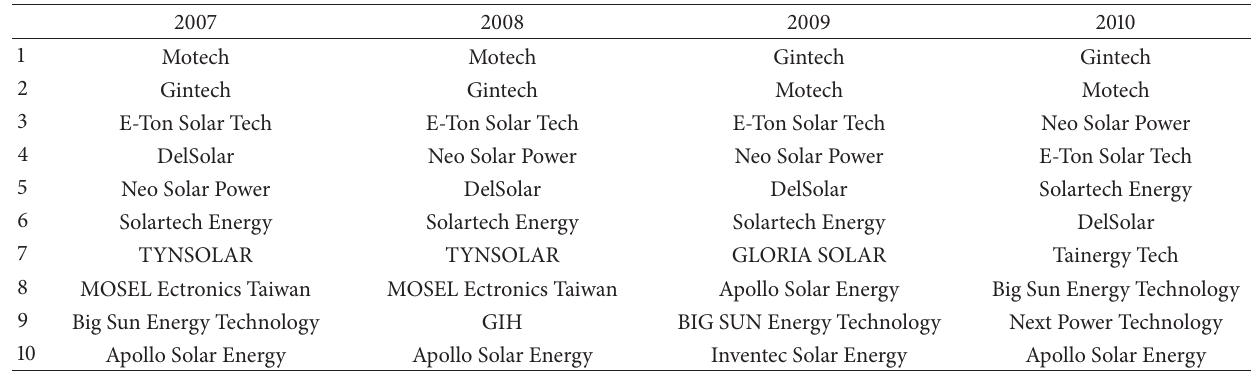
Table 4: Top 10 Taiwanese solar photovoltaic